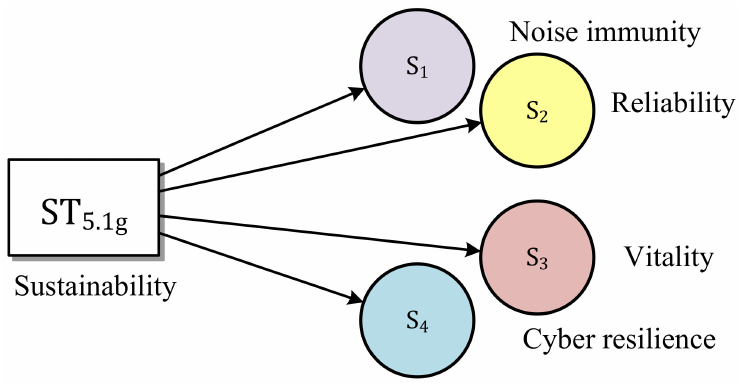
Figure 2. Components of the sustainability graph for the SG